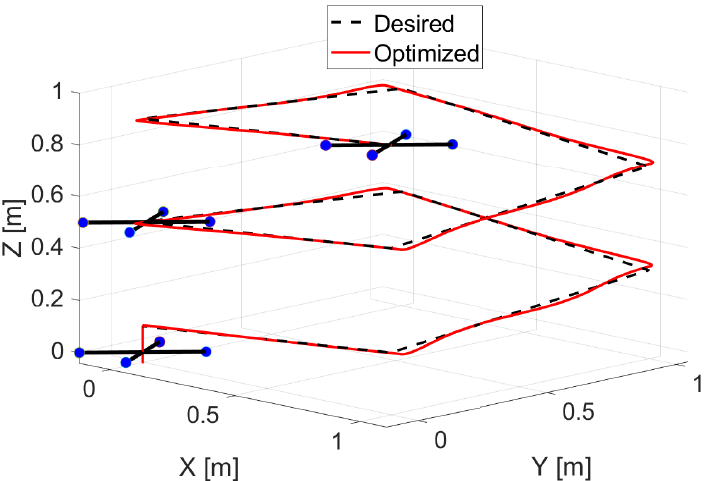
Figure 23. Tracking performance in three–dimensional space with optimized parameters of PID controller using HGS algorithm with 100 individuals.